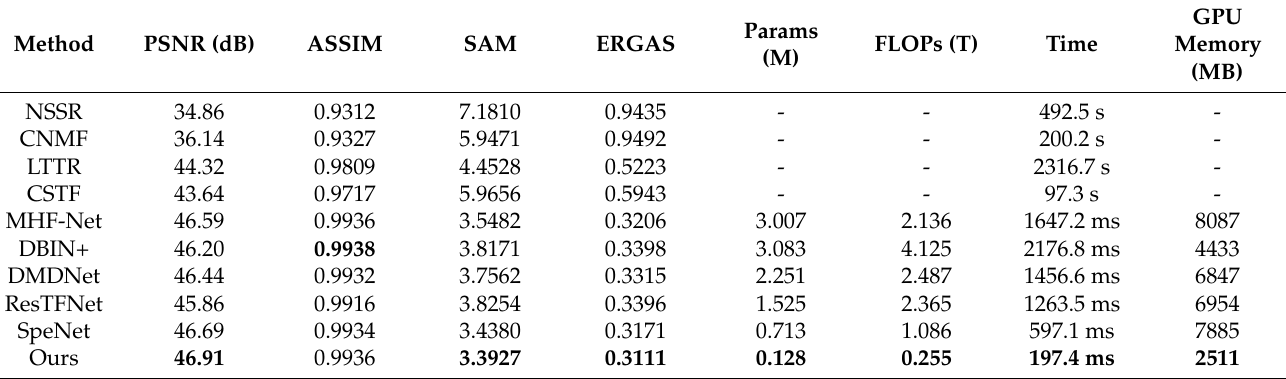
Table 2. Experiment with ten PS methods on the HARVARD dataset. The best performance is shown in